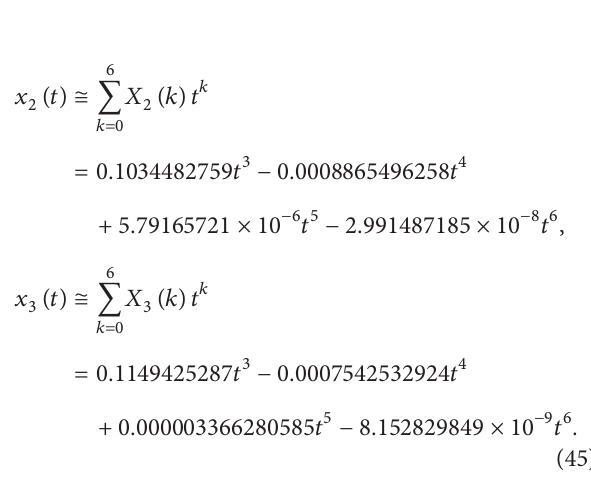
Figure 3: Exponential input signal and absolute error (A.E.) of approximations. The time 𝑡 is expressed in